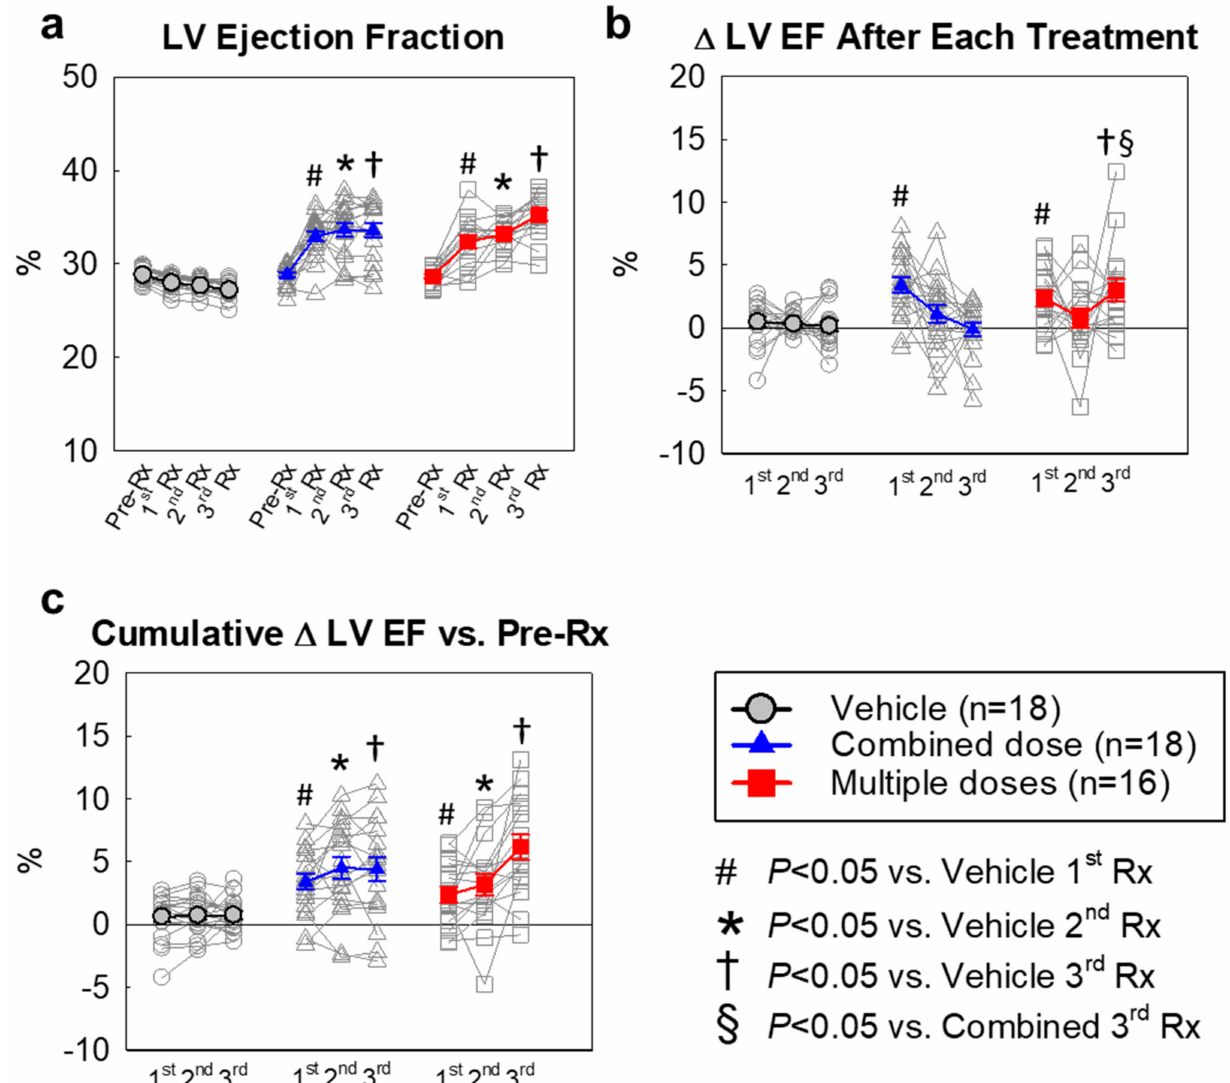
Figure 2. Echocardiographic assessment of left ventricular ejection fraction (LVEF). We interpreted the LVEF value in several different ways (Tables 1–3): (a) Values of LVEF in individual mice; (b) Changes in LVEF (absolute units) after the 1st, 2nd, and 3rd treatments compared with the respective pre-treatment values; ( c ) Cumulative changes in LVEF (absolute units) after the 1st, 2nd, and 3rd treatments compared with the values measured before the 1st treatment. All data are represented as the mean ±